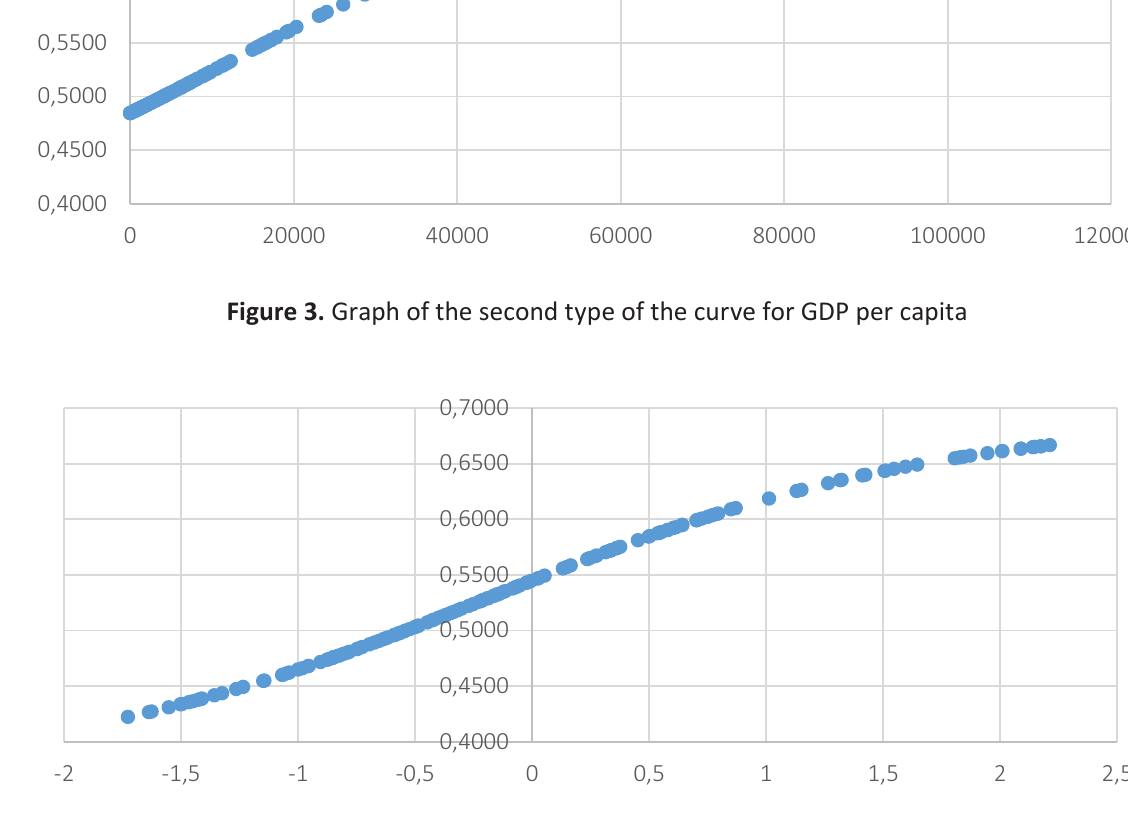
Figure 4. Graph of the first type of curve for Control of corruption: